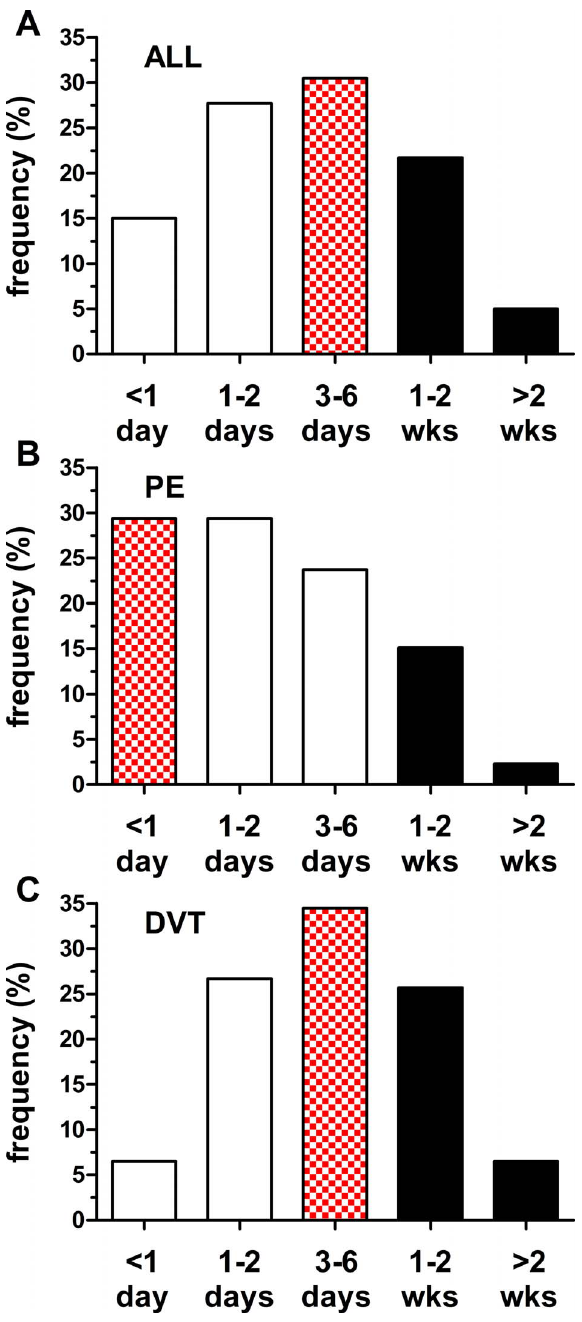
Figure 5. Delay from self-reported symptom onset to emer- gency department arrival. (A) All cases with recorded times (n=1,504). The mode (chequered bar; 31%) occurred at 3–6 days; however, the delay exceeded one week for more than 25% of cases (black bars). (B) Pulmonary embolus (n=557). The mode (29%) occurred in the , 1 day period; proportion with delays exceeding one week was 17%. (C) Deep vein thrombosis (n=947). The mode (35%) occurred at 3–6 days; proportion with delays exceeding one week was 32%. The distribution for deep vein thrombosis differed from that for pulmonary embolus ( P , 0.001; Kuiper’s two sample test).